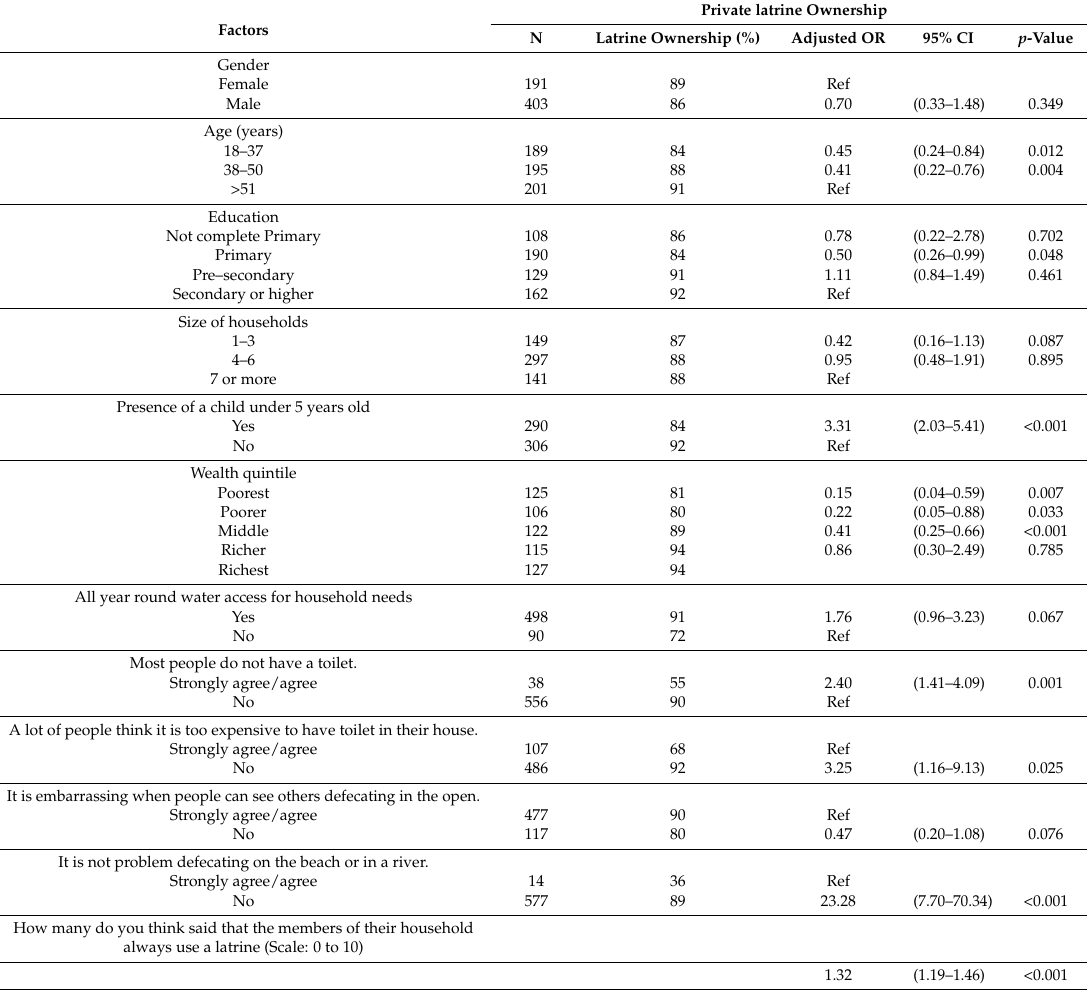
Table 4. Multivariate logistic regression analysis on factors associated with private latrine